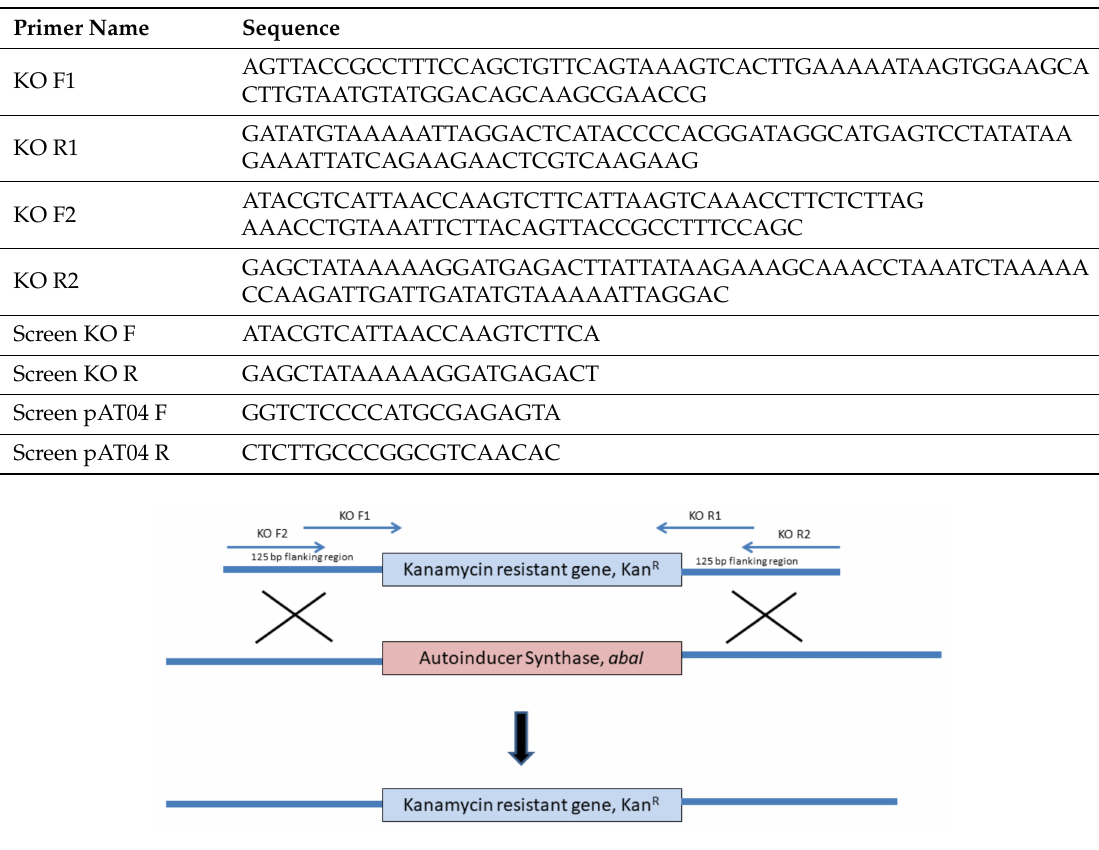
Figure 1. Schematic diagram of the KO cassette construction and abaI deletion process in the cell. Two pair of primers were used to create a selectable marker with 125 bp flanking regions from upstream and downstream of abaI . The gene abaI was replaced with kanamycin resistant gene as a selectable marker with Re AB system from pAT04 transformed into A. baumannii 863